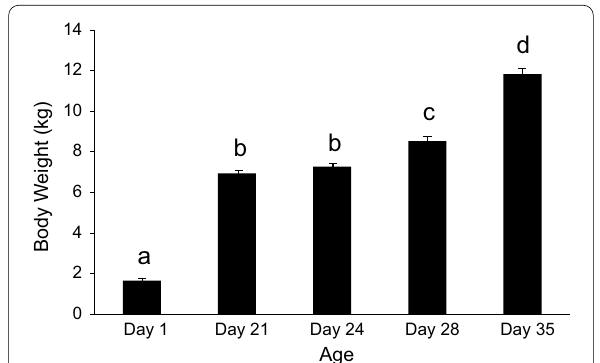
Fig. 1 Body weights of pigs from birth to day 35 of age. Legend: Bars represent means and error bars represent standard errors. Means not sharing a common superscript letter are significantly different . Significant age effect ( P < 0.05), sow effect ( P < 0.0001) and age effect ( P < 0.0001), n =